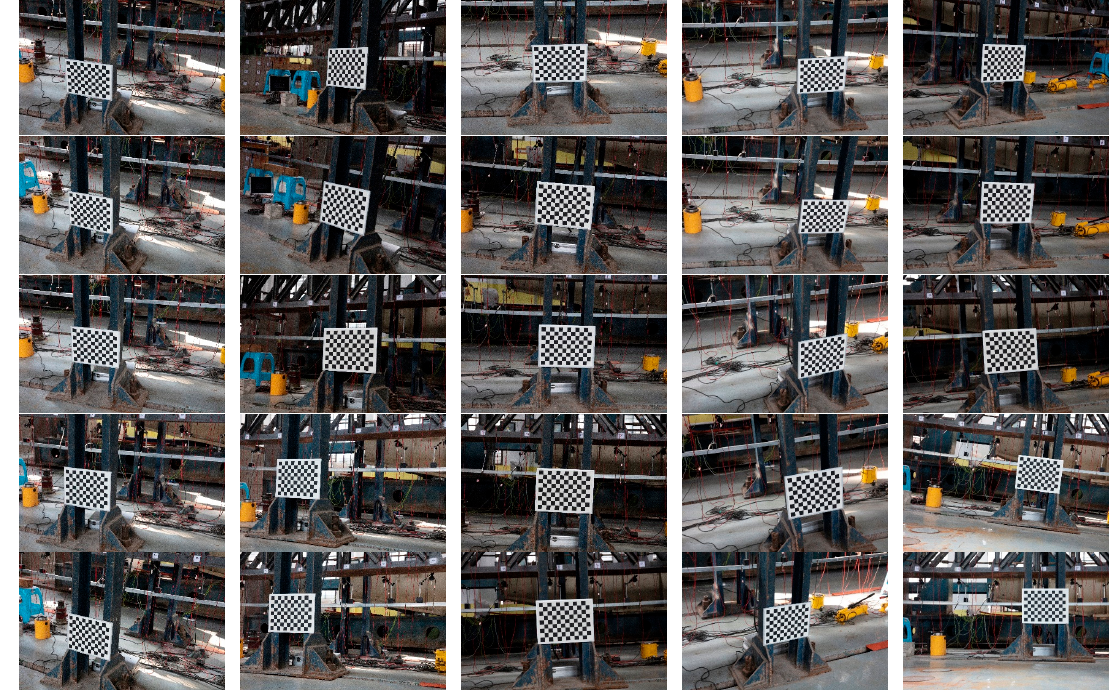
Figure 5. Camera calibration intersection photography.